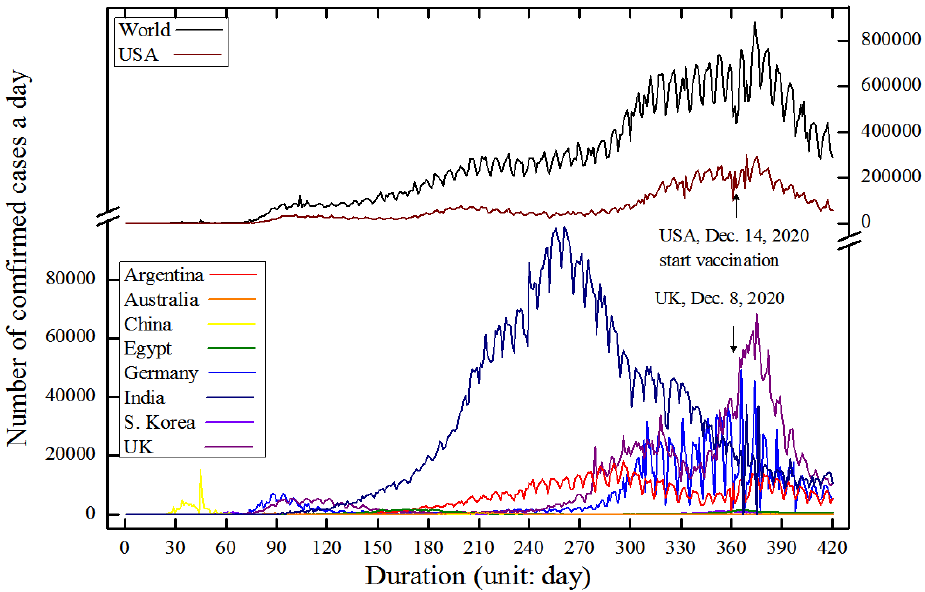
Figure 1. The numbers of daily confirmed cases of COVID-19: World and nine countries for 420 days